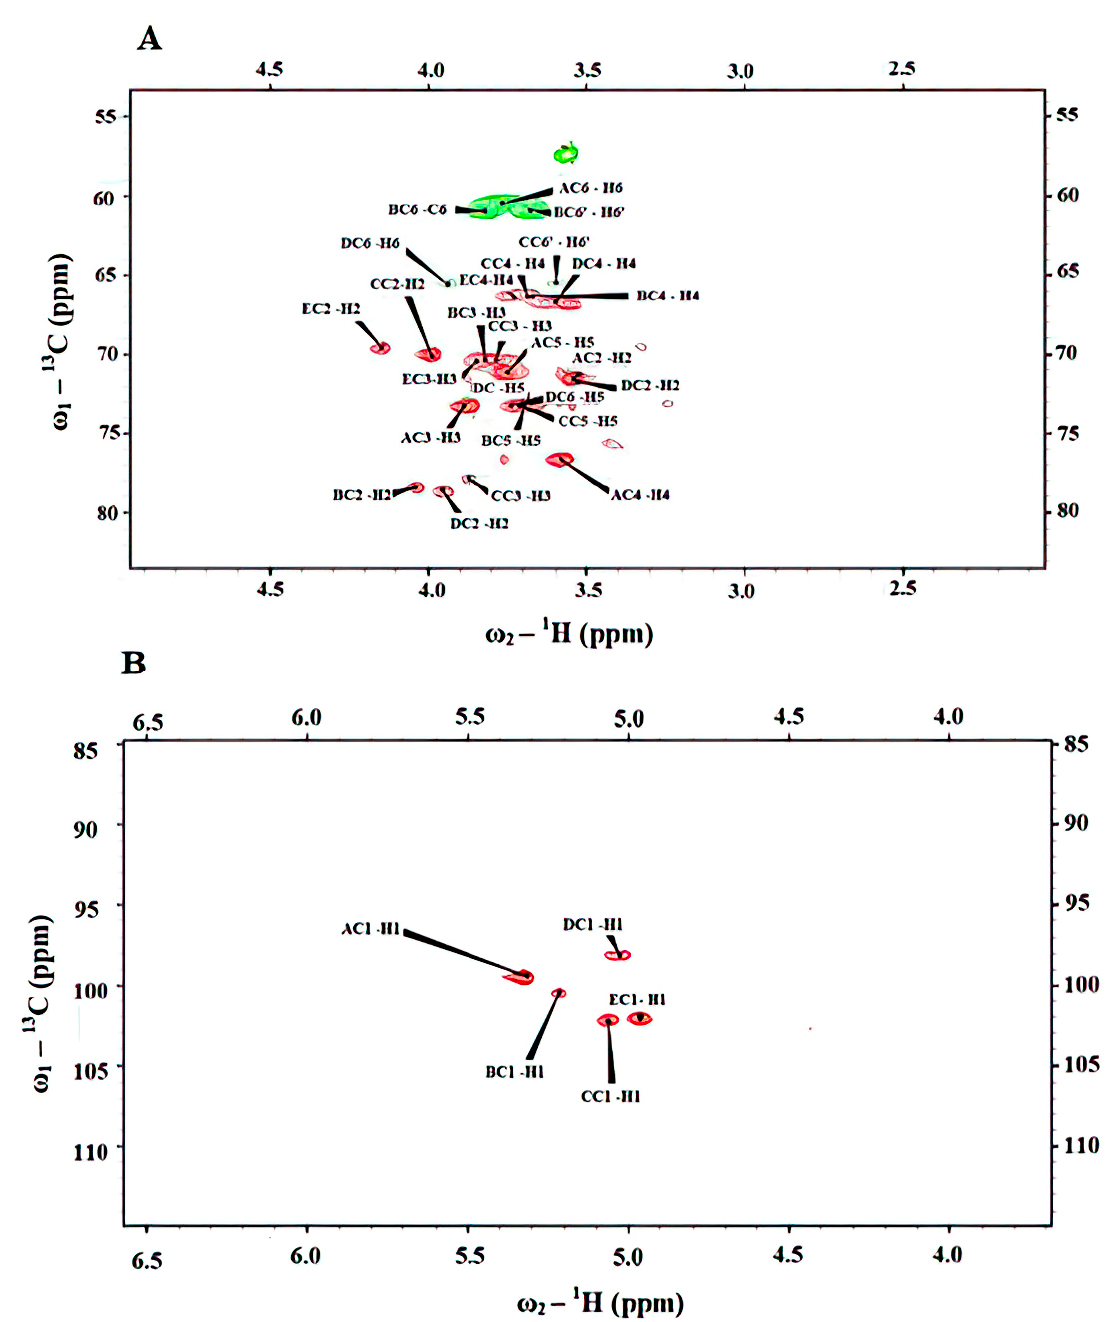
Figure 7. Selected parts of the 1 H- 13 C HSQC NMR spectra of exopolysaccharides. Selected parts of the 1 H- 13 C HSQC NMR spectra of exopolysaccharides: ( A ) region of ring carbons (green colors—negative signals for the CH2, red color—positive signals for the CH carbons), ( B ) region of anomeric carbons in the ring.